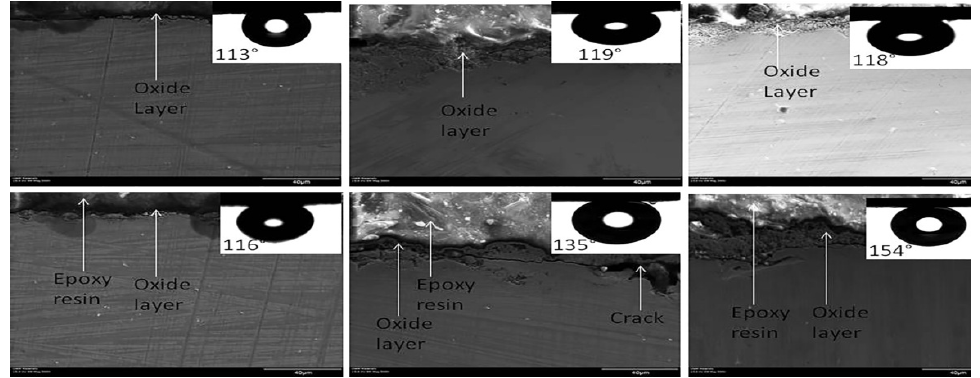
0.75 wt. % O gas mixture; ( d – f ) oxidized in 2 2